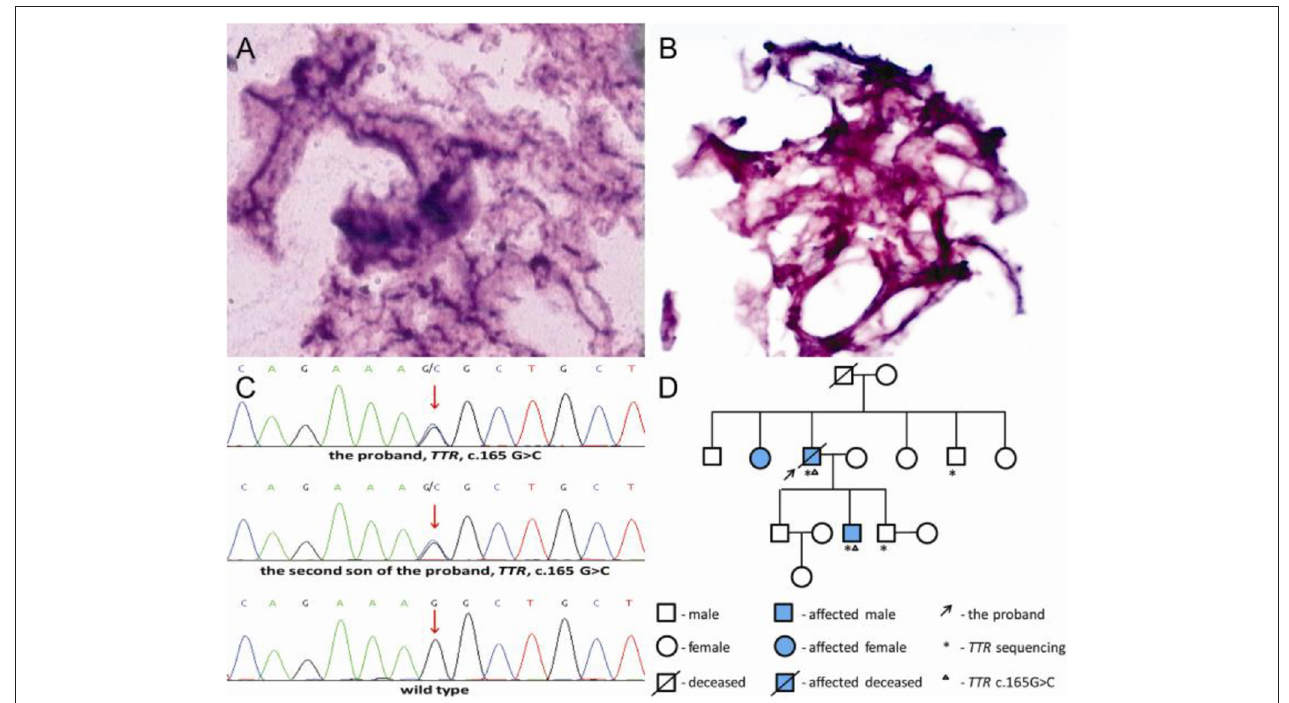
FIGURE 3 | Histopathological examination and transthyretin ( TTR ) gene sequencing. (A) Hematoxylin-eosin (H&E) staining revealed degeneration vitreous; (B) Congo-red staining positive revealed amyloid vitreous; (C) The patient was heterozygous for a TTR c.165 G > C mutation and his second son carried the same mutation; (D) Pedigree of the